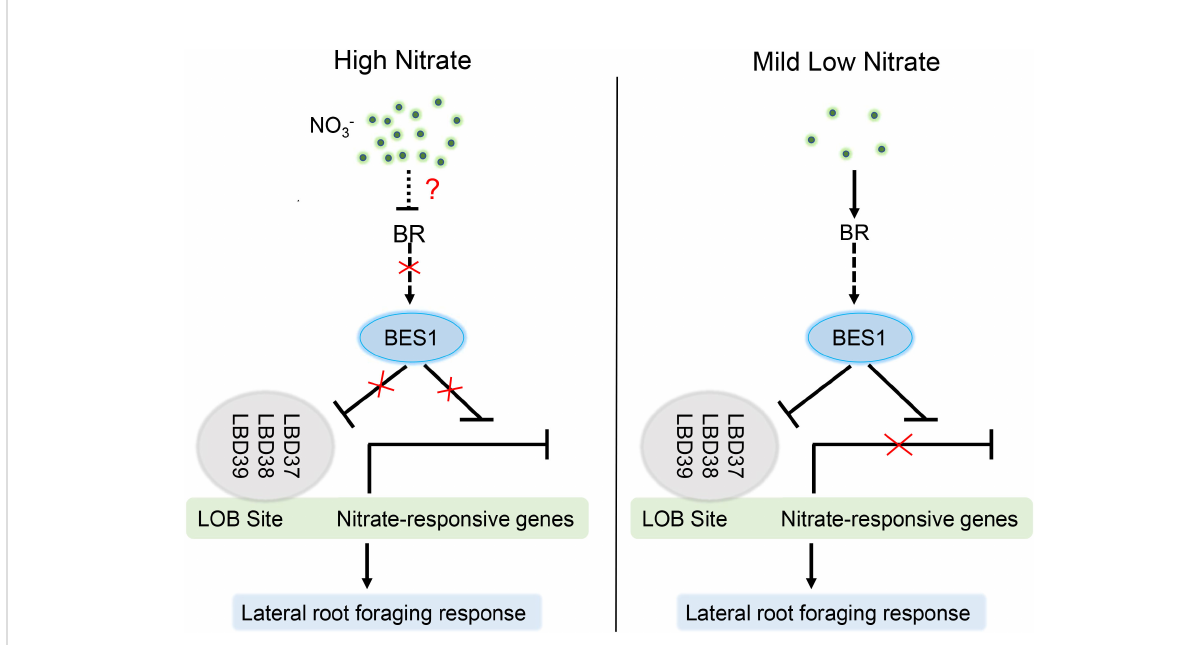
FIGURE 8 Proposed model to illustrate how BES1-LBDs cascade integrates BR and LN response to precisely fi ne-tune lateral root growth. Under HN conditions, high concentration of nitrate inhibits BR level and promotes the phosphorylation of BES1 (inactivation) through an unknown mechanism. Inactivated BES1 failed to interact with LBD37/38/39 or suppresses their expression, resulting in binding of LDBs to LN-responsive genes promoters and reduction of their transcript level and thus inhibitory of lateral root growth. At mild nitrogen de fi ciency, LN induces the accumulation of BES1 transcript and dephosphorylation via promoting BR biosynthesis. Activated BES1 can suppress the expression and DNA binding ability of LBDs, and thus enhance the expression of LN-responsive genes, which stimulate lateral root growth and development in response to LN, commonly described as nitrogen foraging